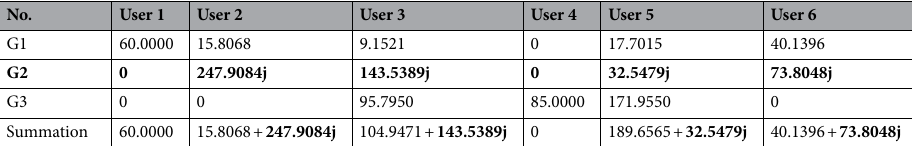
Table 2. Unit-load carbon emission flow incidence matrix (complex structure carbon intensity). Significance values are in bold.